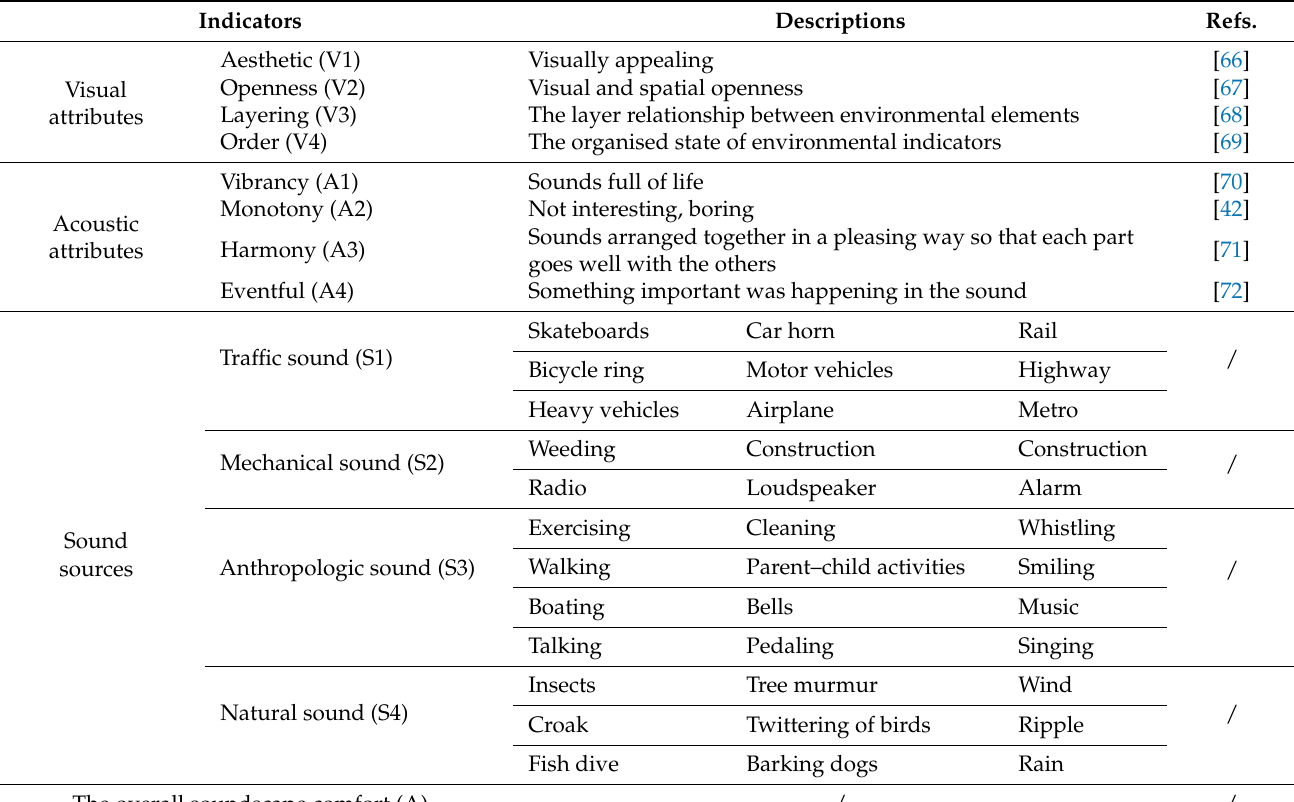
Table 2. Indicators of measuring visual and acoustic attributes and sound sources.